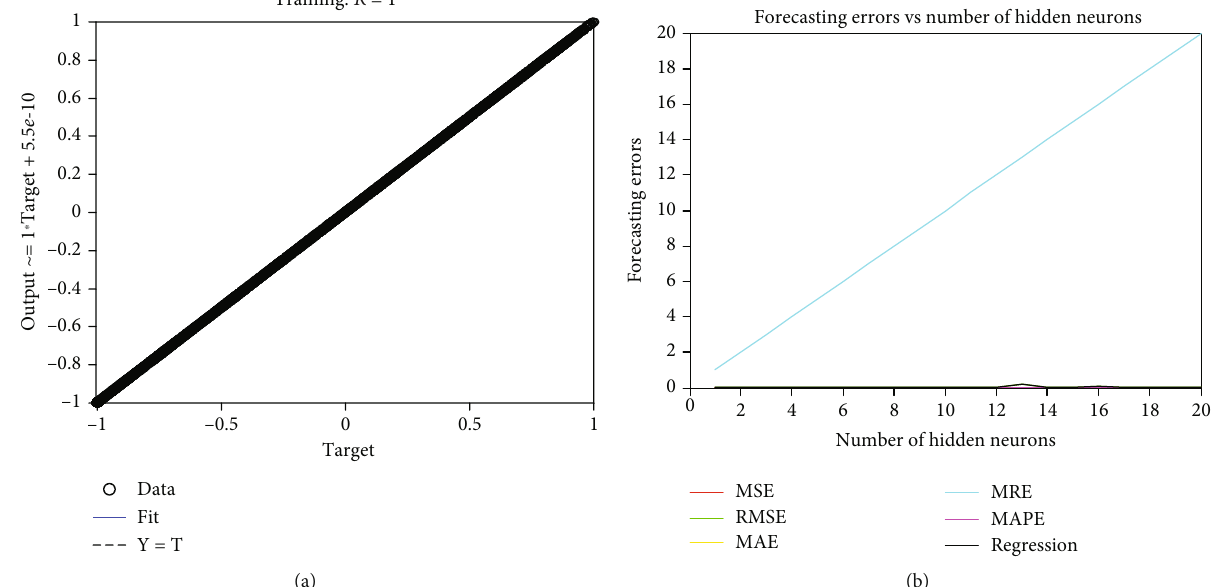
Figure 9: (a) Three input MLPNN-based forecasting model regression graphs. (b) Three input MLPNN-based forecasting model forecasting errors vs. the number of hidden neurons.